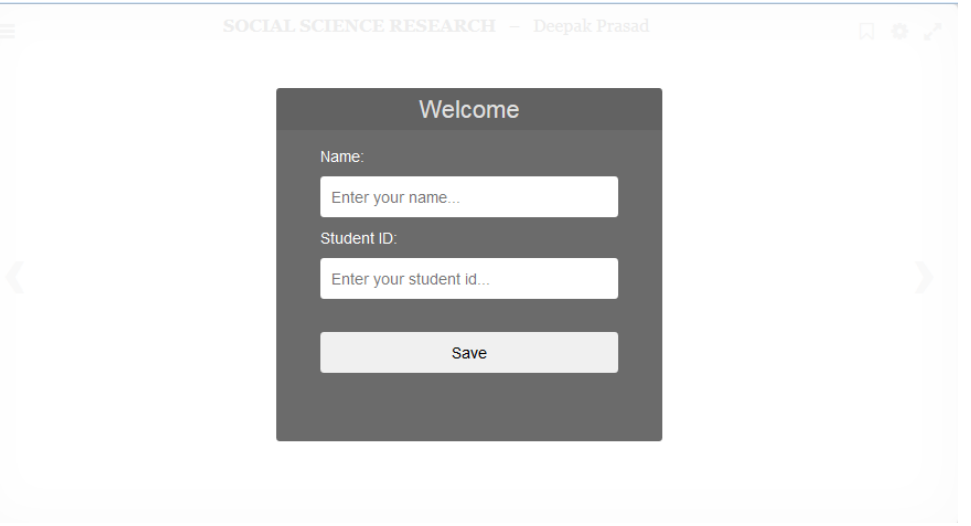
Figure 5 . Authentication interface .